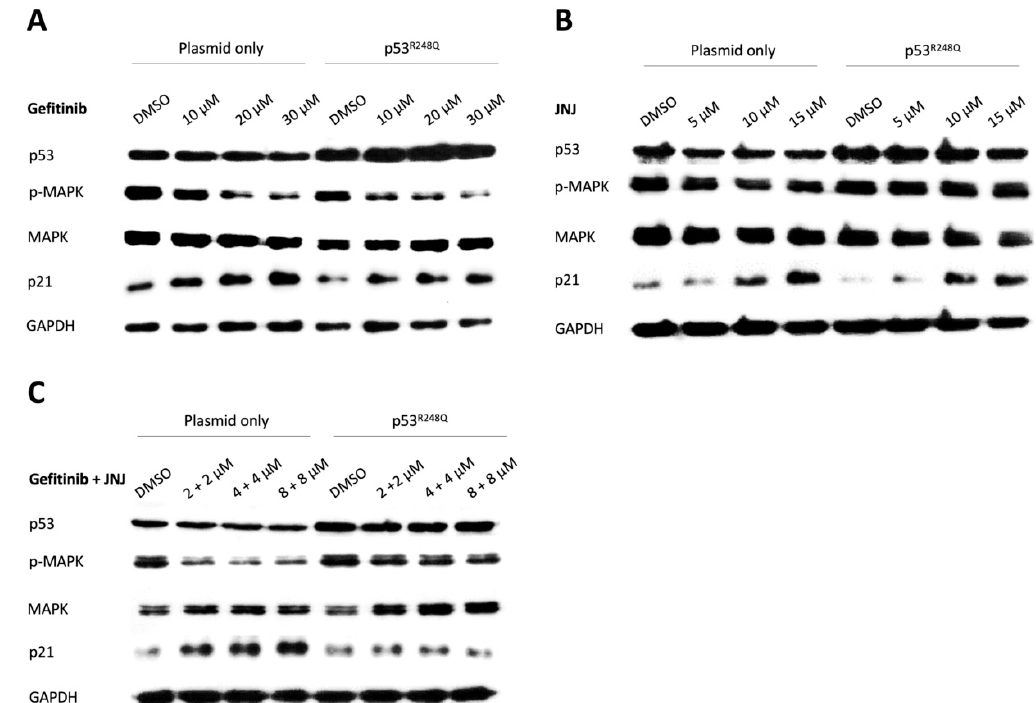
Figure 6. MAPK and p21 regulated the effects of single and combined treatment of gefitinib and JNJ. OVCAR3 cells were pre-transfected with either empty plasmid or p53 R248Q plasmid before treatment with various doses of gefitinib (10, 20 or 30 μ M), JNJ (5, 10, or 15 μ M), or gefitinib + JNJ (2 + 2, 4 + 4, or 8 + 8 μ M) for 24 h. ( A ) The level of p-MAPK was significantly reduced with increasing doses of gefitinib. The dosage-dependent inhibition of p-MAPK displayed an even more profound effect in the p53 R248Q -overexpression group. The level of p21 was upregulated in both groups with increasing doses of gefitinib. The dosage-dependent upregulation of p21 was not significantly different between the two groups. ( B ) With increasing doses of JNJ, the level of p-MAPK decreased slightly in the plasmid-only group, while sustained level of p-MAPK was detected in the p53 R248Q -overexpression group. The level of p21 was upregulated significantly with increasing doses of JNJ. Despite the lower level of p21 in the DMSO control of the p53 R248Q -overexpression group, the dosage-dependent upregulation of p21 was greater in the p53 R248Q -overexpression group than in the plasmid-only group. ( C ) With increasing doses of the gefitinib–JNJ combination, the level of p-MAPK significantly decreased in the plasmid-only group, but not in the p53 R248Q -overexpression group. Moreover, the level of p21 increased with a profound effect in the plasmid-only group, but not in the p53 R248Q -overexpression group. GAPDH expression was measured to serve as a loading control.